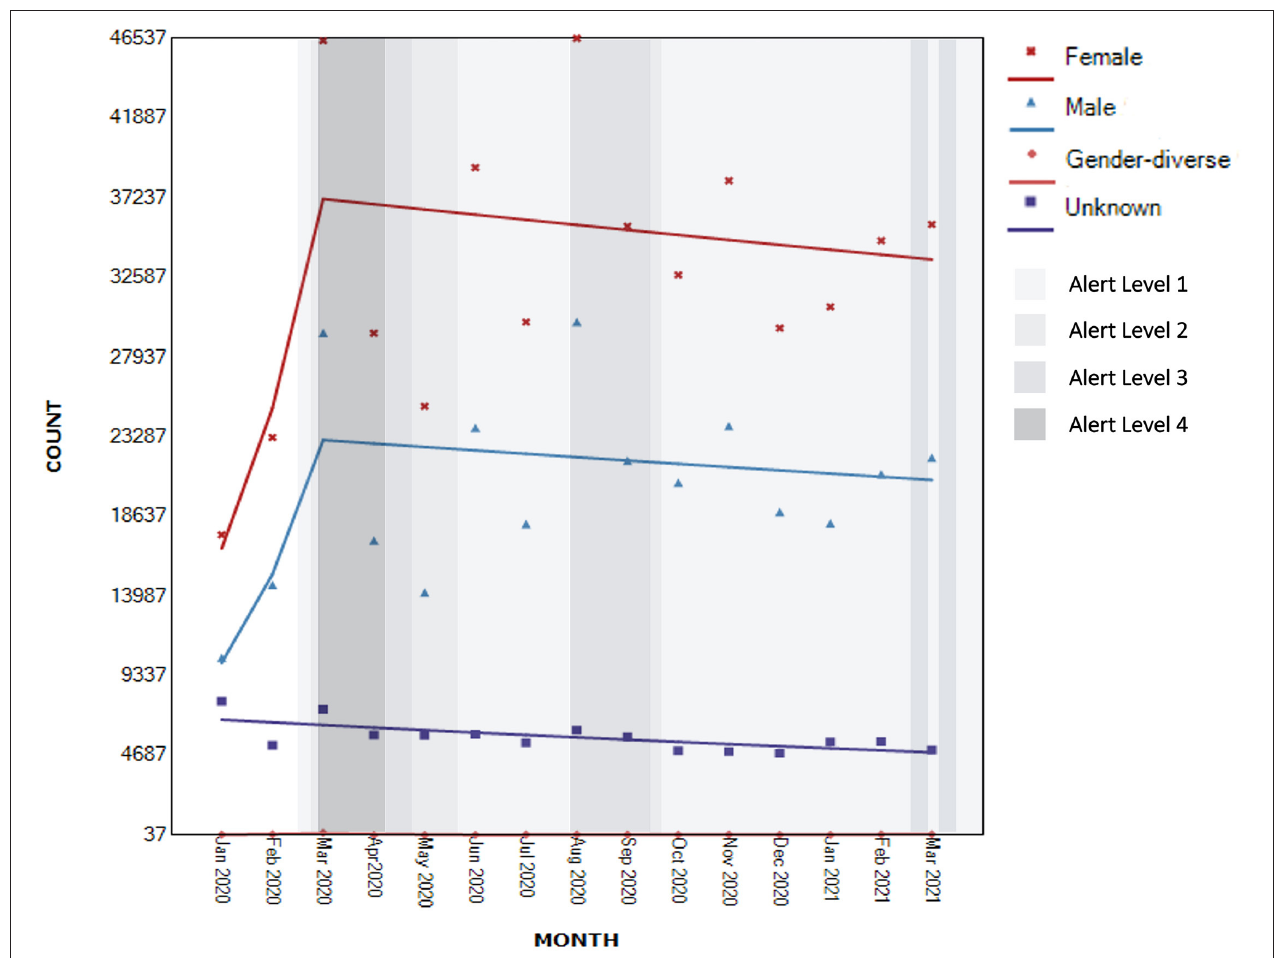
FIGURE 6 | Segmented regression analysis of contacts to national helplines by gender ( N known =